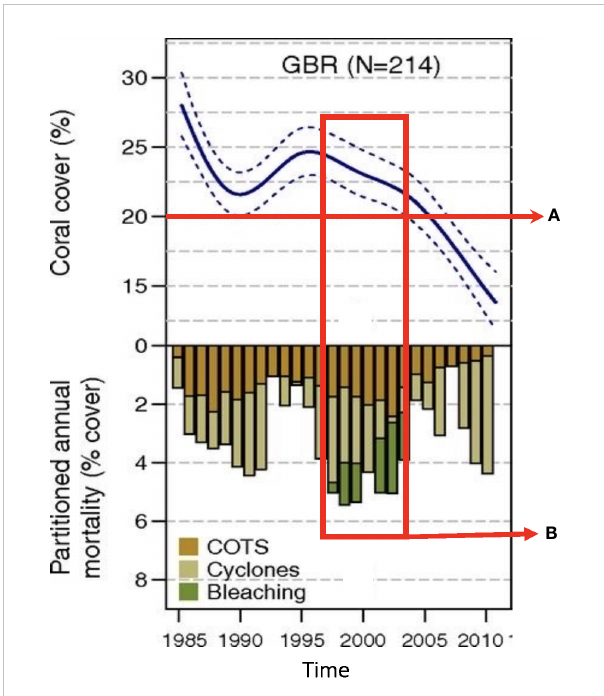
FIGURE 3 Monitoring for severe population declines and extreme events can inform the timely implementation of aquaculture. Proactive, ongoing monitoring of reef populations and for multiple stressors provides the data with which to assess the need for and timing of aquaculture interventions. Top Panel: temporal trends in coral cover for the Great Barrier Reef over the period 1985 – 2012 (N, number of reefs). (A) Aquaculture can be implemented proactively when a minimum population threshold is reached, here a loss of overall live coral cover to below 20% remaining (red line), circa 2008. Lower panel: annual coral mortality due to Crown of Thorns Seastar predation (COTS, orange), cyclones (light green), and coral bleaching (dark green). (B) Aquaculture interventions can be triggered by prolonged or multiple extreme events co-occurring with continued or severe decline of populations, here repeated bleaching events co-occurring with COTS, cyclones, and declining coral cover (red box), circa 2000. Figure modi fi ed from De ’ ath et al. PNAS